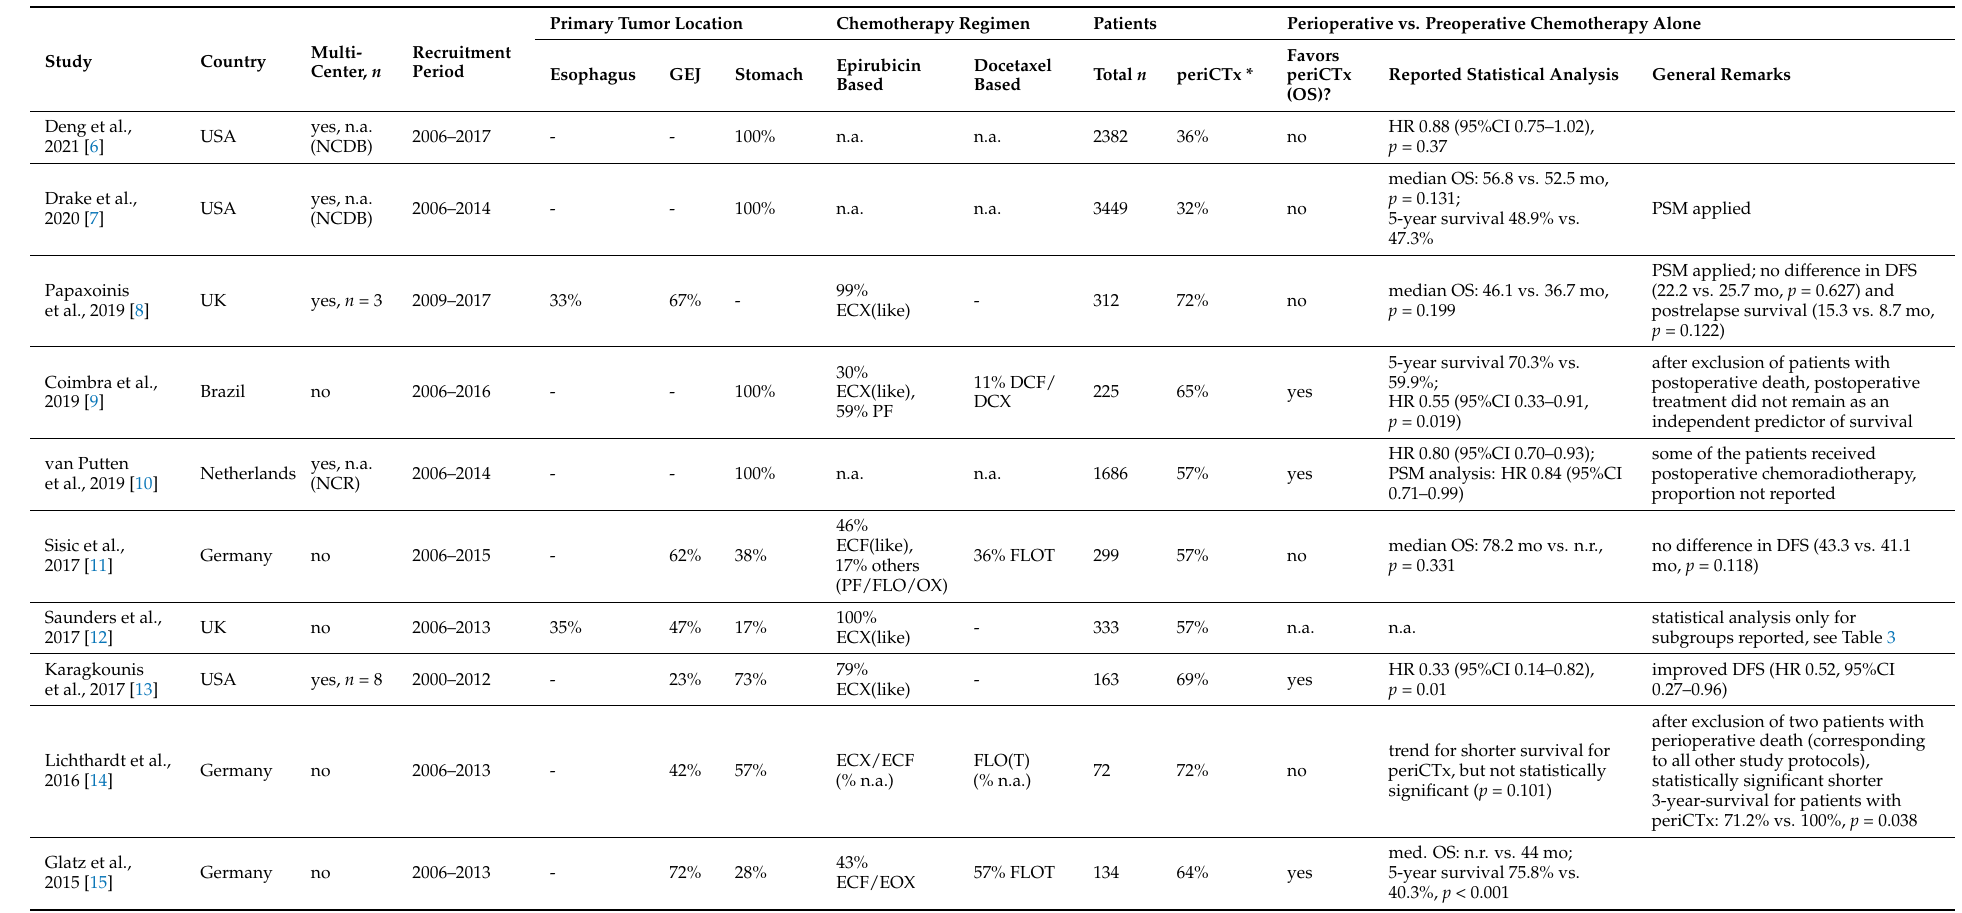
Table 2. Characteristics of retrospective